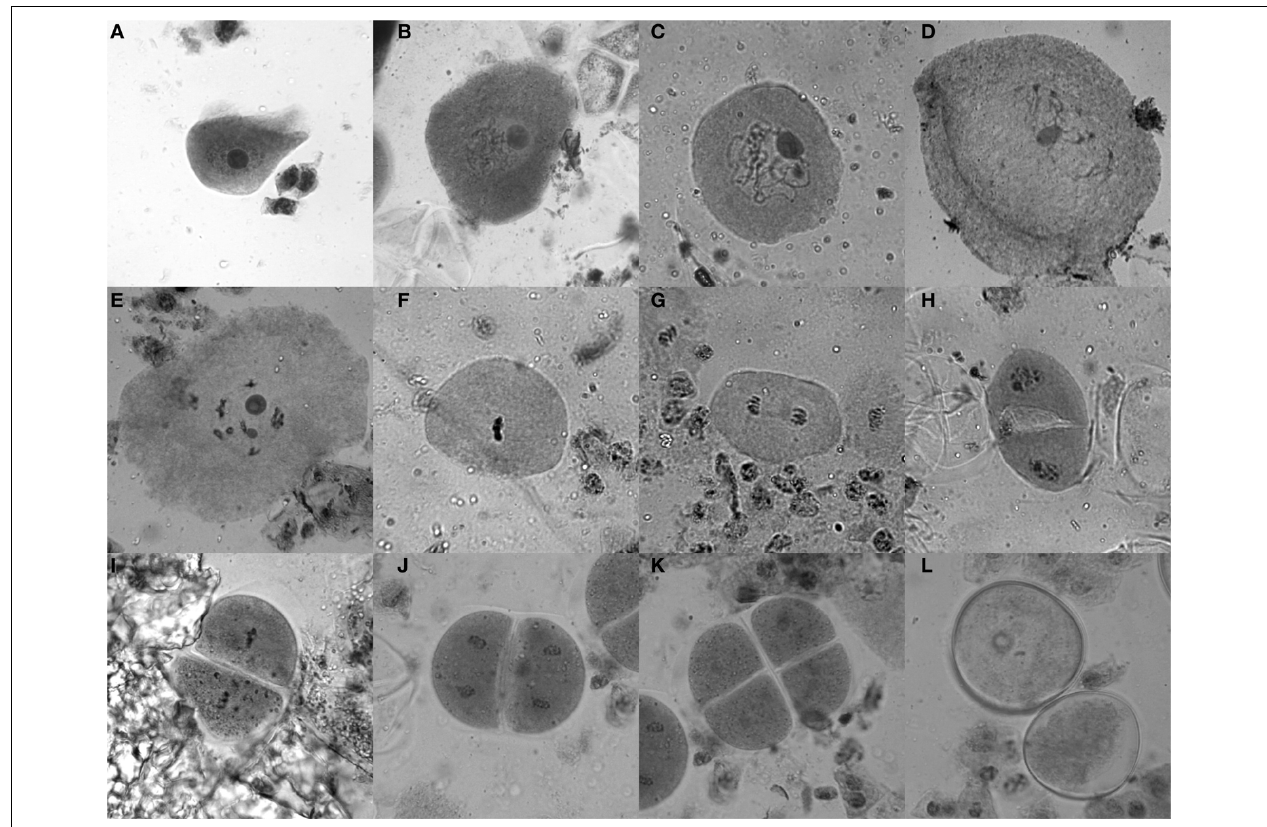
FIGURE 2 | Acetocarmine staining of maize meiotic stages. (A) Leptotene, (B) Zygotene, (C) Pachytene, (D) Diplotene, (E) Diakinesis, (F) Metaphase I, (G) Anaphase I, (H) Telophase I/Interphase/Prophase II, (I) Metaphase II, (J) Anaphase II, (K) Tetrad stage, (L)